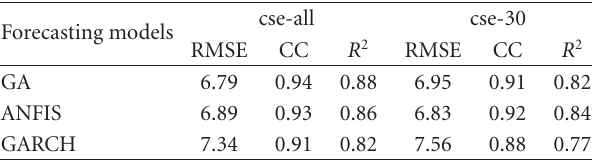
Table 8: Performances for training data.